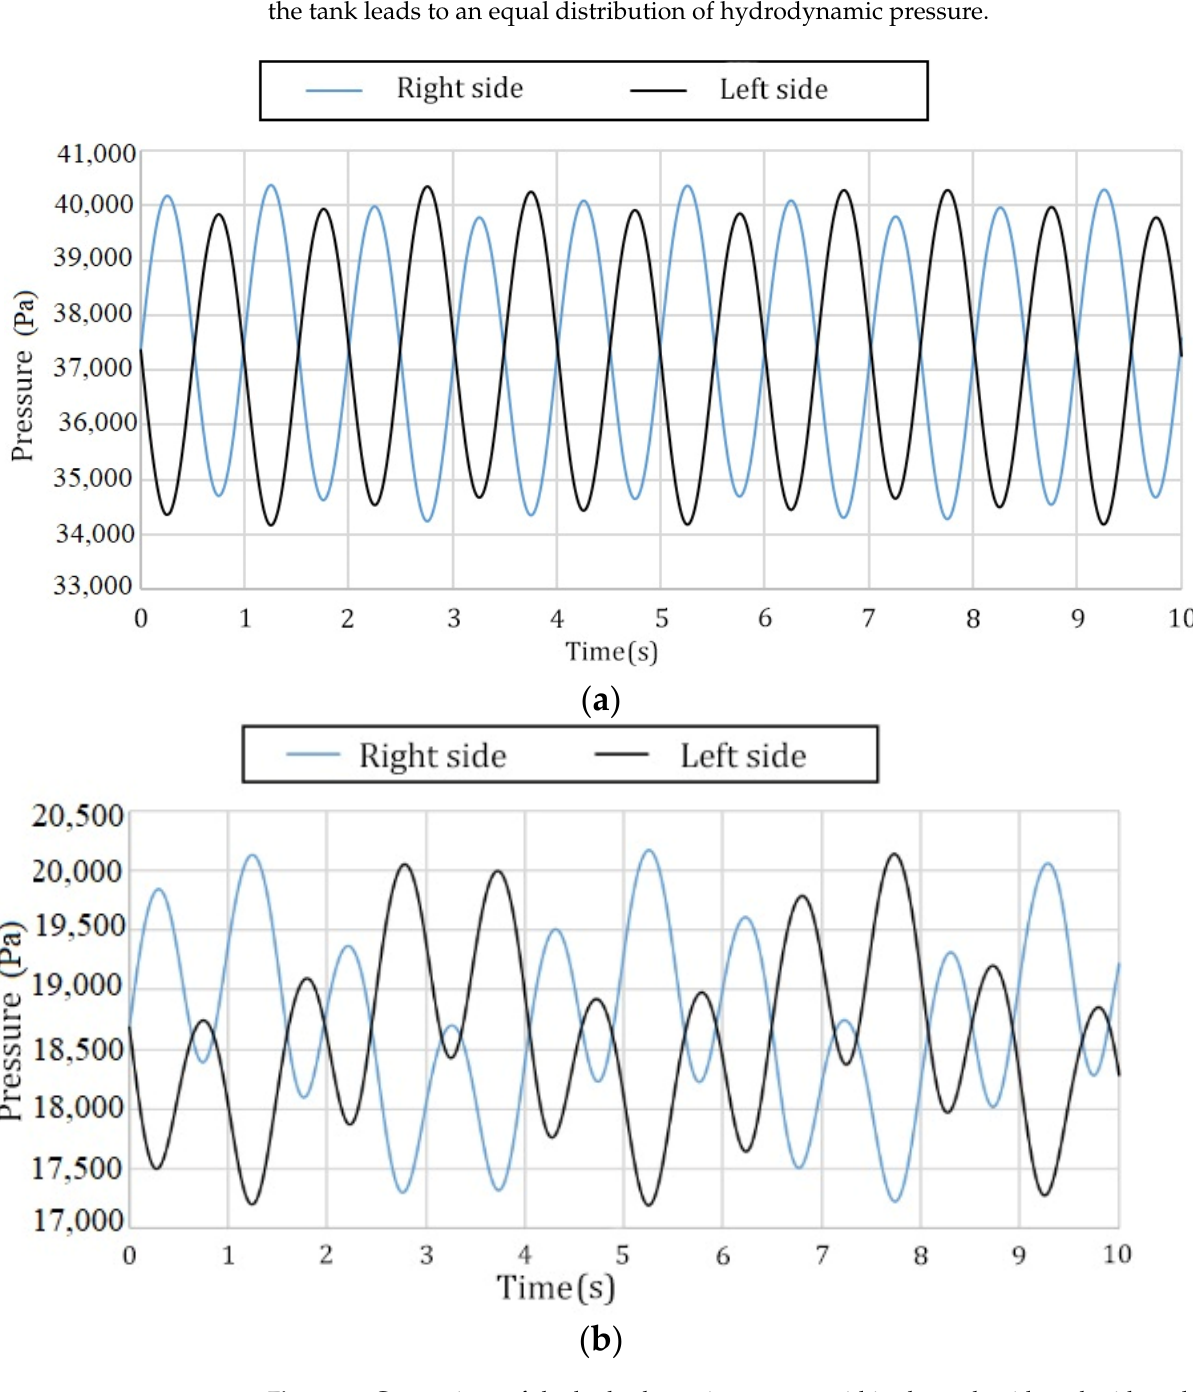
Figure 7. Comparison of the hydrodynamic pressure within the tank with and without baffles. ( a ) The hydrodynamic pressure in the tank with no baffles in points 12 and 1; ( b ) the hydrodynamic pressure in the tank with a baffle in points 12 and 1.